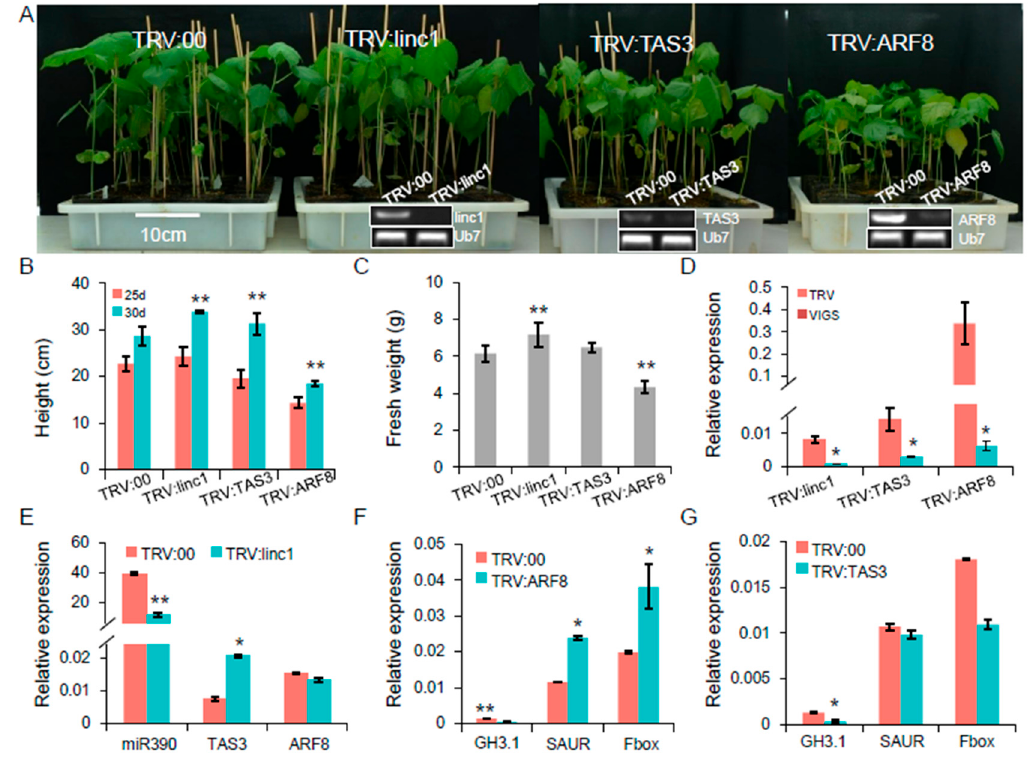
Figure 8. Functional of the miR390-mediated pathway using the virus-induced gene silencing (VIGS) technology. ( A ) Phenotype for TRV:linc1 , TRV:TAS3 and TRV:ARF8 plants. At the bottom of the electrophoresis figure confirmed down-regulation of VIGS target genes in TRV:linc1 , TRV:TAS3 and TRV:ARF8 plants compared with TRV:00 . ( B , C ) Plant height and fresh weight on VIGS plants. ( D ) qRT-PCR analysis of linc1 , TAS3 and ARF8 expression in different VIGS plants. ( E ) Silencing linc1 leads to down-regulation of miR390 in TRV : linc1 plants. ( F , G ) qRT-PCR analysis of auxin-related genes in TRV:ARF8 and TRV:TAS3 plants.